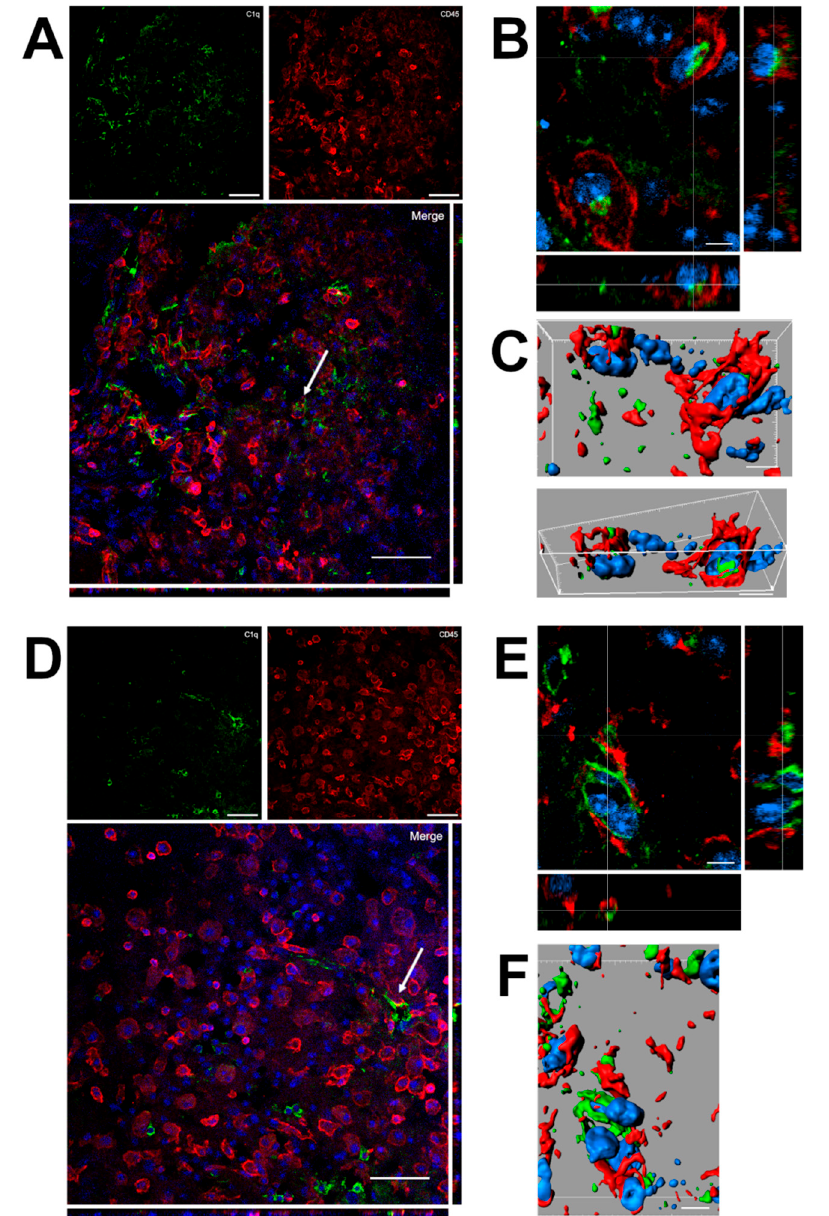
Figure 6. ( A – F ). Confocal analysis of C1q and microglia/macrophage reciprocal localization in the contused cortex 96 h after TBI. ( A and D ) C1q (green) does not generally colocalize with microglia/macrophages (Cd45, red) although it appears in close proximity to them (arrow in A). C1q appears with vessels-like morphology (arrow in D), as shown in Figure 5. Scale bar = 50 µ m. ( B , C ). High magnification, three-dimensional image rendering shows C1q localization inside Cd45 positive cells. ( E , F ) High magnification, three-dimensional image rendering shows C1q surrounded by microglia/macrophages. Images are representative of at least two independent experiments. Nuclei are in blue. Scale bar = 5 µ m. Figure 7 shows confocal analysis of C1q and astrocyte localization in the contused cortex 96 h after TBI. C1q is present along the border of the lesion, but it does not specifically co-localize with